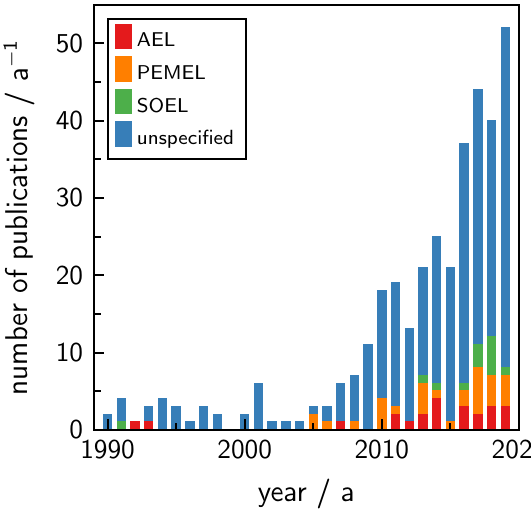
Figure 1. The number of publications per year from 1990 to 2019 containing the specified keywords. Around 2010, the publication rate increases due to greater interest in the energy turnaround. While the topic is often discussed technology-independently (unspecified), more publications for low-temperature technologies, like alkaline water electrolysis (AEL) and proton exchange membrane electrolysis (PEMEL), are available than for the high-temperature technology solid oxide electrolysis (SOEL)